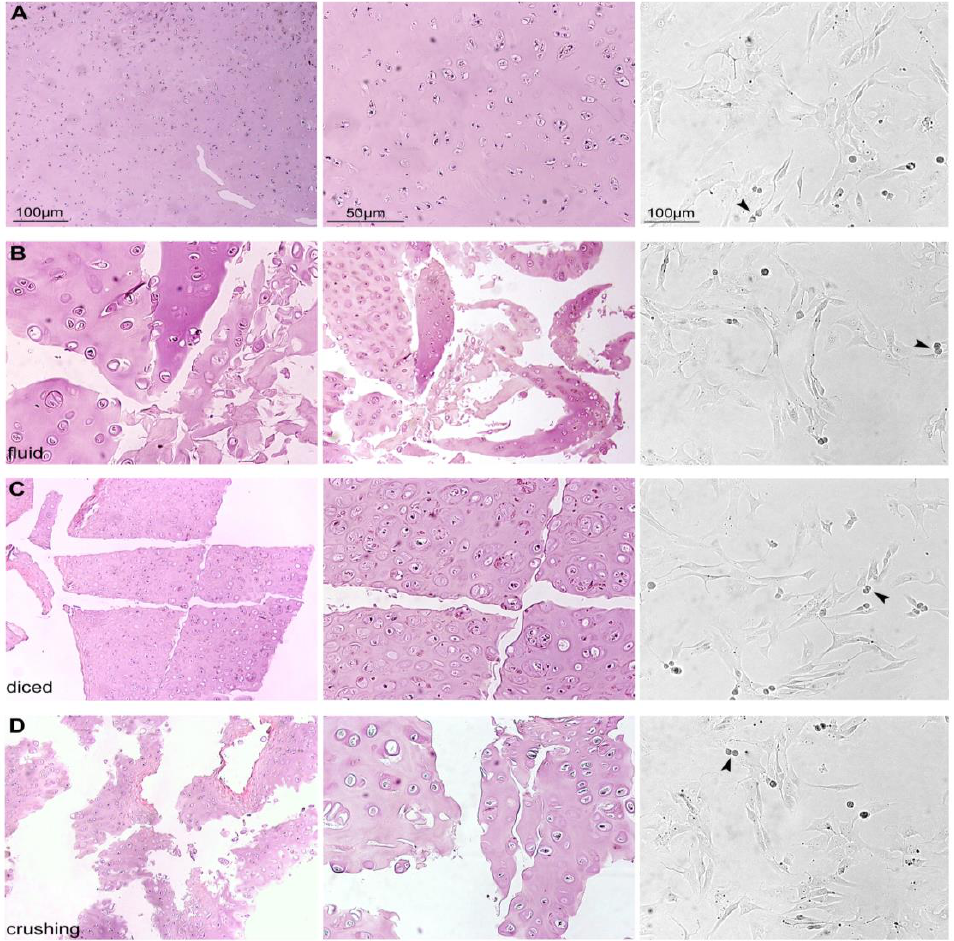
Figure 3. Histological and morphological analysis of cartilage tissue and cultured human chondrocytes (HCs) from different procedures . ( A – D ) Haematoxylin – eosin-stained paraffin-embedded sections of cartilage samples from the different procedures (left and center) and the corresponding cultured HCs (right); from top to bottom: whole cartilage, fluid, diced, and crushing samples. Arrow head, mitosis.